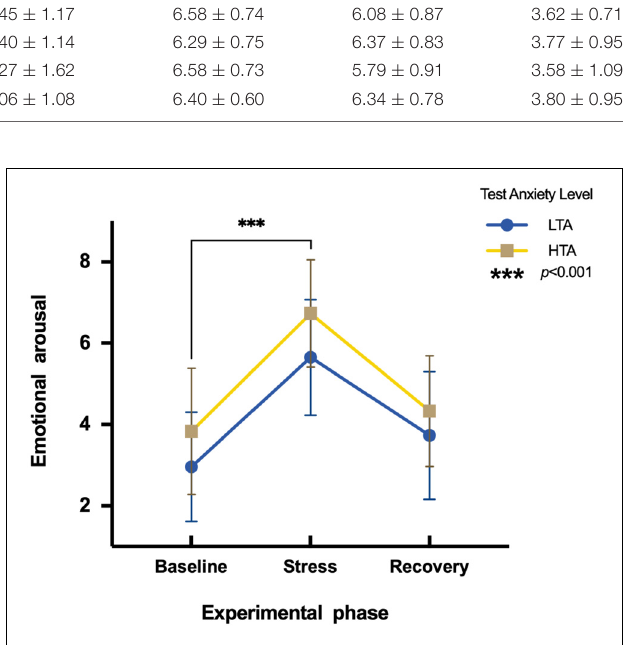
FIGURE 2 | Differences in emotional arousal during three experimental phases of HTA and LTA individuals. ∗∗∗ represents a significant difference between the baseline and stress phase of both groups with p -value <